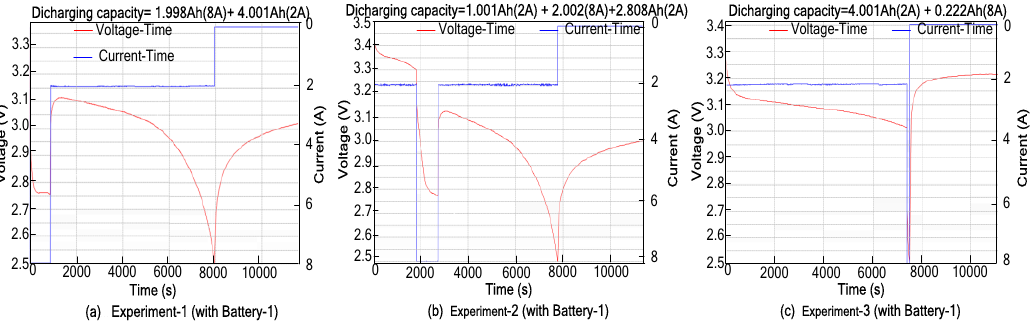
Figure 6. The influences of discharge order. ( a ) Experiment-1 (with Battery-1); ( b ) Experiment-2 (with Battery-1); ( c ) Experiment-3 (with Battery-1).